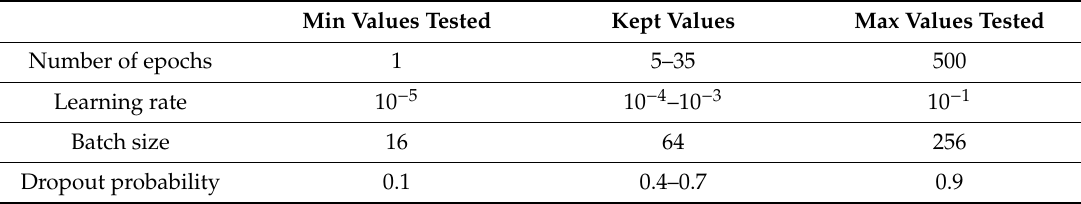
Table 2. Hyperparameters values tested in the frame of our work.